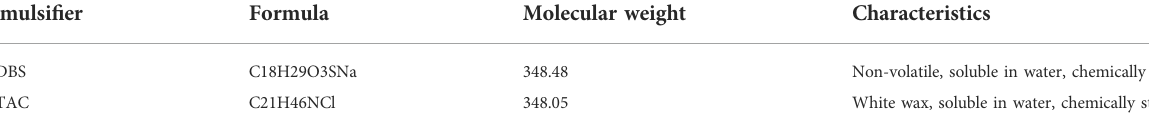
emulsi fi ed asphalts as an example, the fl ow chart is shown in Figure 6. The preparation process and procedures are as follows: